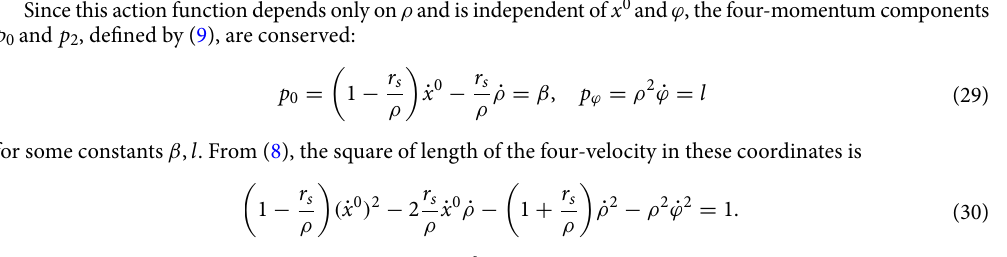
This corresponds to (15) for the quadratic four-potential of a single source. As shown later, this four-potential predicts exactly the anomalous precession of Mercury’s orbit, while a four-potential of the form (14) leads to an incorrect precession. If a gravitational field is generated by several spherically symmetric, non-rotating bodies, then the Newtonian limit implies that the acceleration of the field is the sum of accelerations due to each source. This is equivalent to the assumption that the rank 3 tensor G in the equation of motion (13) is the sum of the rank 3 tensors of each source. To understand the change in the geometry due to gravitation, compare the 2D section of the light cone for u 0 = 1 in flat spacetime with spacetime influenced by the gravitational field of a Black Hole, see Fig. 2. Observe that the Black Hole pulls the light cone toward itself, but leaves it inside the cone of flat spacetime. Thus, even in presence of a strong gravitation field, the speed of a moving object, as observed by an inertial observer, will be bounded by the speed of light. We show now that the motion in a gravitational field of a spherically symmetric body defined by the action function (28) passes the tests of GR . Consider the motion of an object in gravitational field of a spherically sym- metric mass M centered at the origin of our inertial frame. As shown above, the 3D acceleration of the object is in the radial direction. Thus, if (cid:31) is the plane in R 3 generated by the position vector x ( 0 ) of the moving particle and its velocity v ( 0 ) at the initial time, the acceleration will also be in (cid:31) . This implies that the motion of the particle will remain in (cid:31) for all times. By rotating the axes, assume that (cid:31) is the x 1 , x 2 plane, or x 3 = 0 . Use polar coordinates ρ , ϕ in the plane x 1 , x 2 and ̺ , φ in the plane u 1 , u 2 , and τ defined by (8). In these coor-